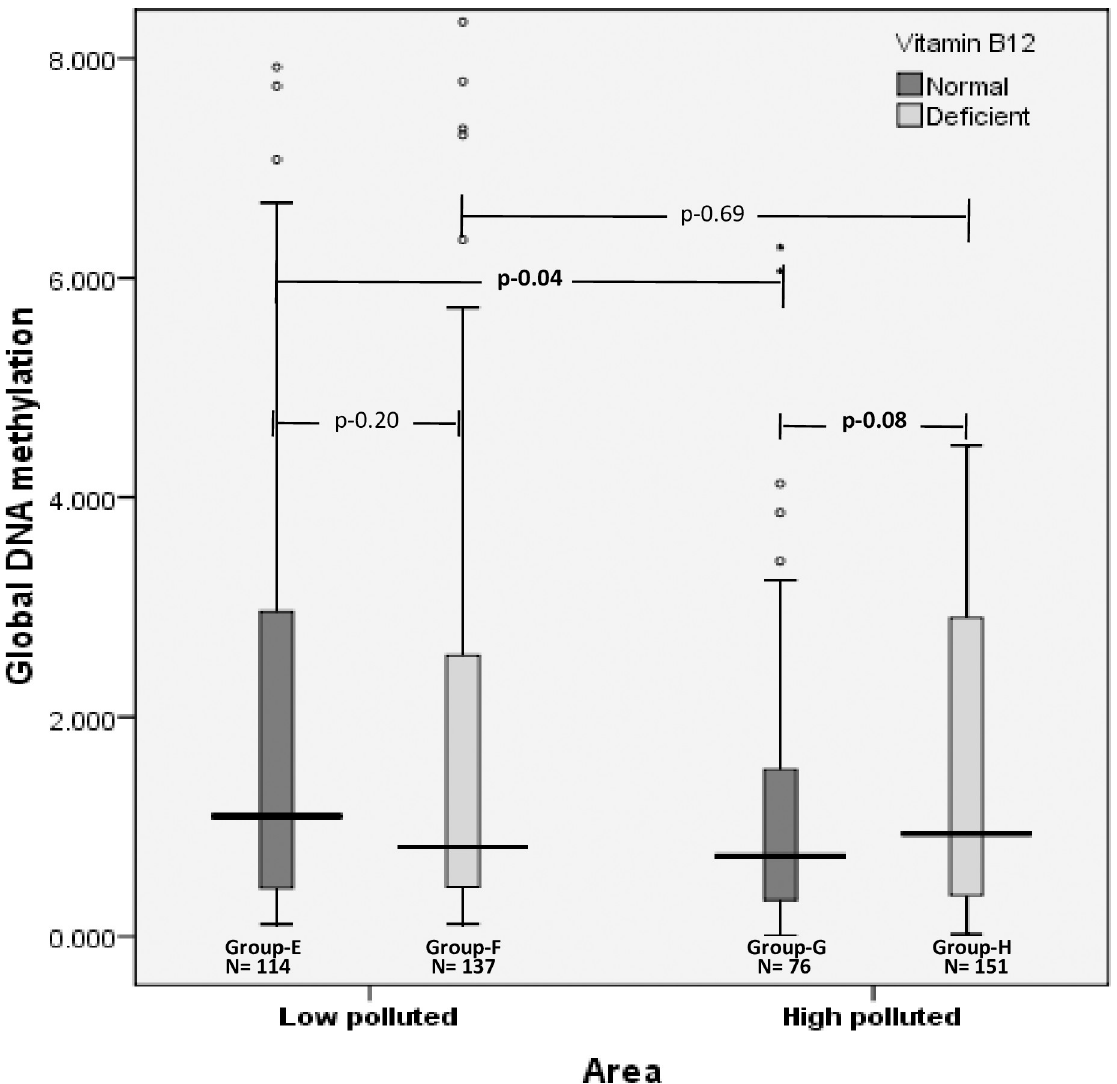
Fig 4. Distribution of median levels of global DNA methylation levels with respect to vitamin B 12 deficiency in low and high polluted areas.